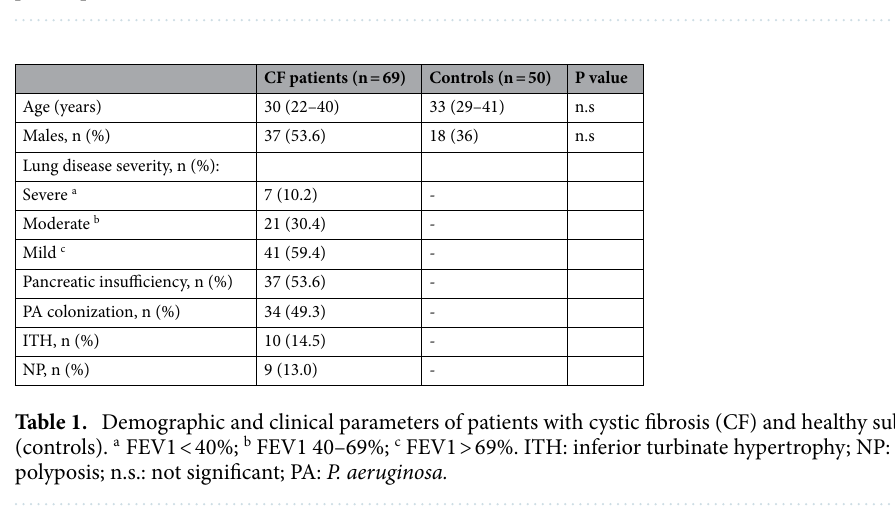
Figure 2. Univariate ROC curve analysis for EpETE, DHET, PGB2, and 20-hydroxyPGF2A. Red lines in box plots represent the best cut-off values.